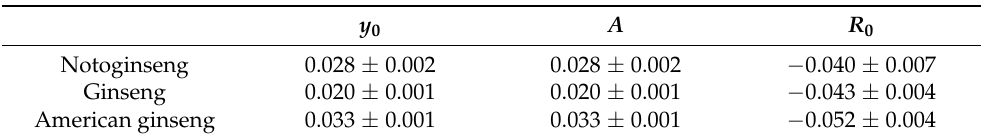
Table 1. Parameters values corresponding to the fitting curves of notoginseng, ginseng and American ginseng. y 0 A R 0 Notoginseng 0.028 ± 0.002 0.028 ± 0.002 − 0.040 ± 0.007 Ginseng 0.020 ± 0.001 0.020 ± 0.001 − 0.043 ± 0.004 American ginseng 0.033 ± 0.001 0.033 ± 0.001 − 0.052 ±